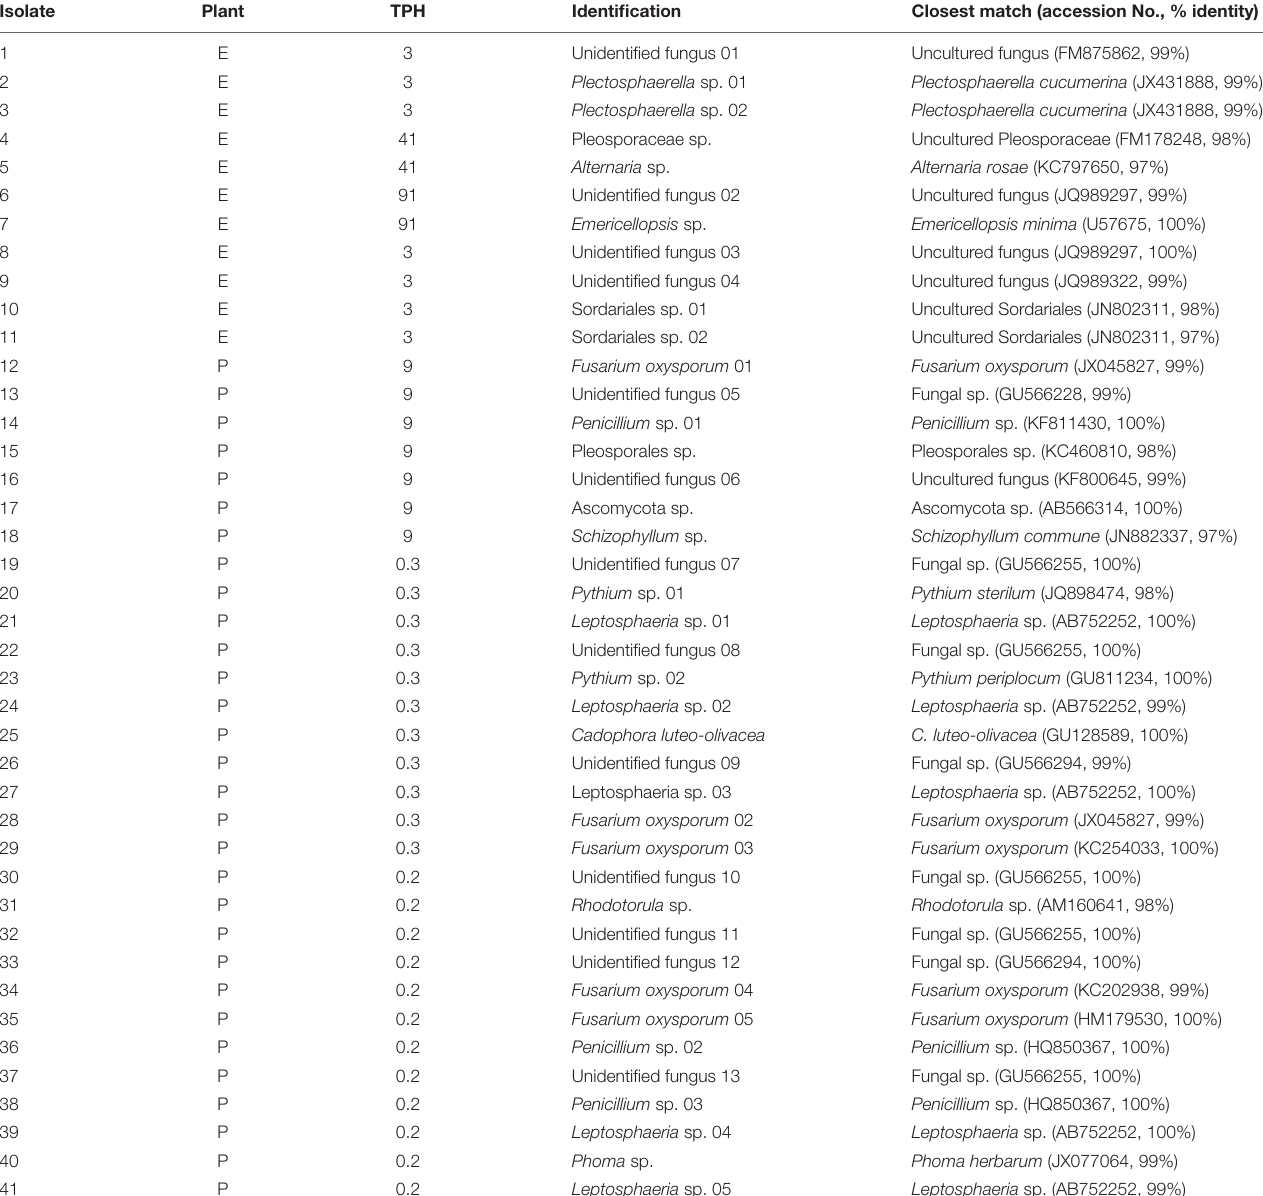
TABLE 2 | List of isolated endophytic fungal isolates from surface-sterilized roots of E. erythropoda (E) and P. balsamifera (P).